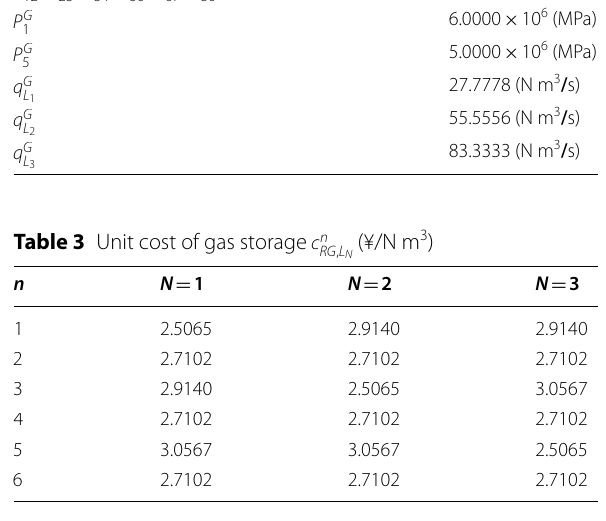
Table 4 Unit cost of thermal inertia c n